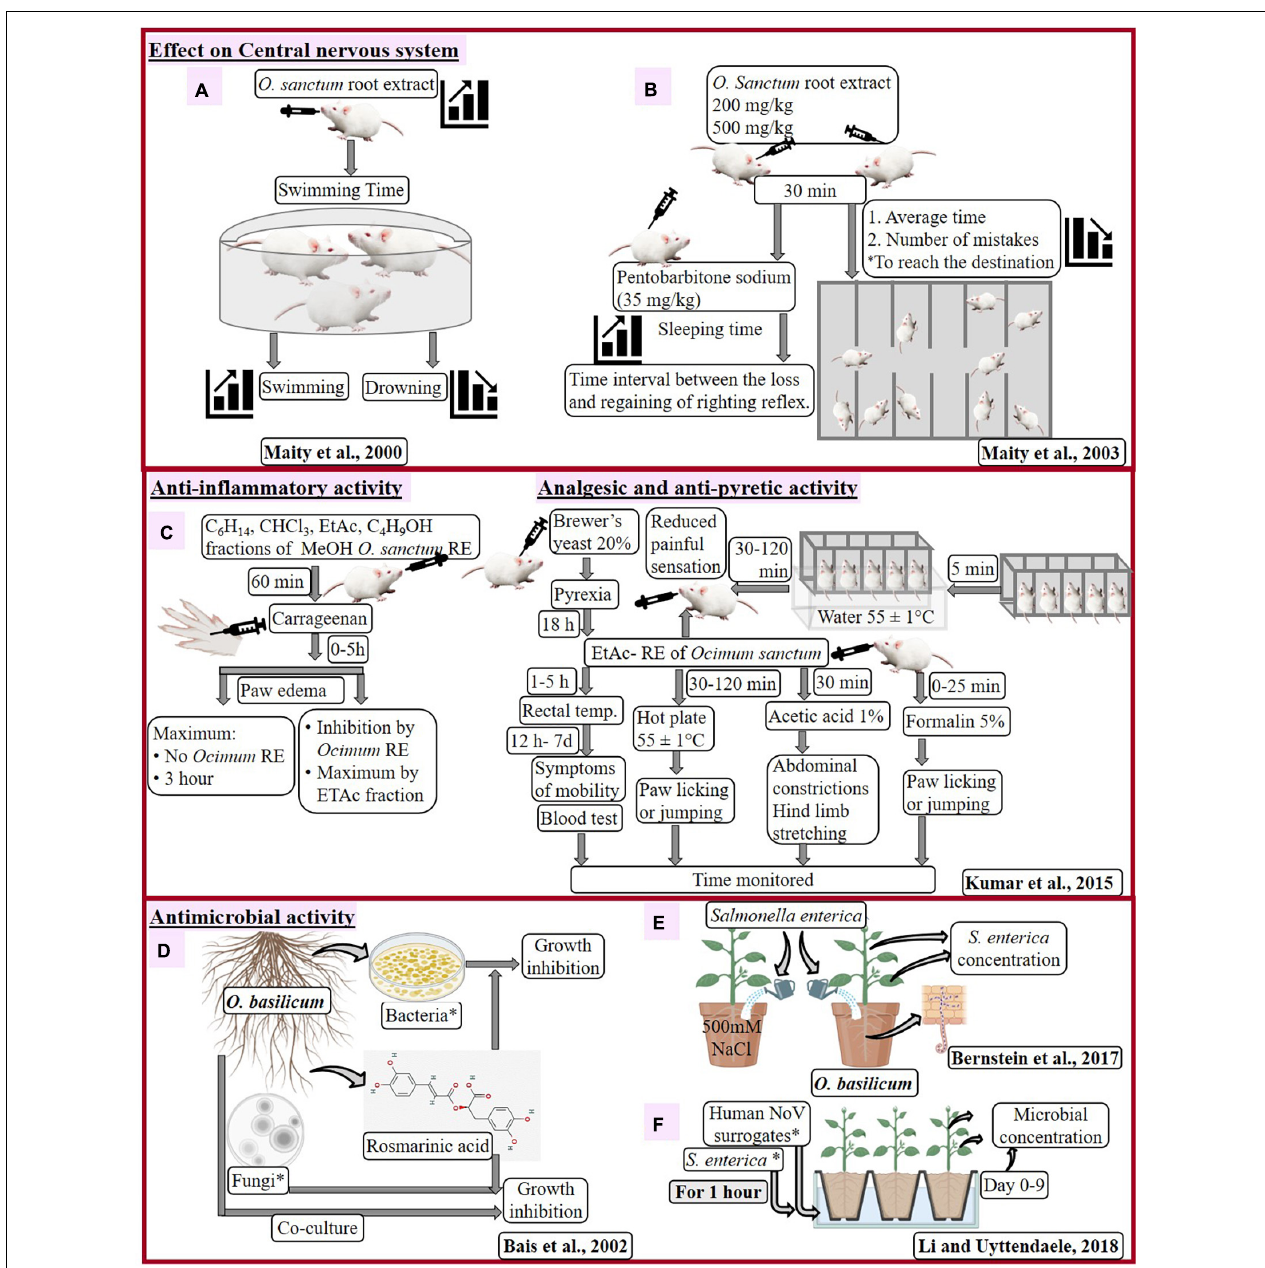
FIGURE 3 | Effect of Ocimum sanctum root extract on central nervous system of mouse (A,B) , pharmacological activities of O. sanctum RE in the mouse model (C) and antimicrobial activity of Ocimum basilicum (D–F) . *C 6 H 14 , hexane; CHCl 3 , chloroform; EtAc, ethyl acetate; C 4 H 9 OH, butanol; RE, root extract; Bacteria: Xanthomonas campestris , Pseudomonas fluorescens , P. aeruginosa (strains PAO1 and PA14), Erwinia carotovora ; Fungal isolates: Alternaria brassicae , A. solani , Phytophthora megasperma , P . parasitica , P. drechsleri , P. ultimum , A. niger , Rhizoctonia solani , Fusarium oxysporum , Pythium aphanidermatum , Verticillium dahliae ; S. enterica : 3-strains serovar Typhimurium SL 1344, serovar Thompson RM1987 and serovar Thompson FMFP 899; human noroviruses (NoV) surrogates: Murine norovirus-1, i.e., MNV-1 and Tulane virus, i.e., TV.